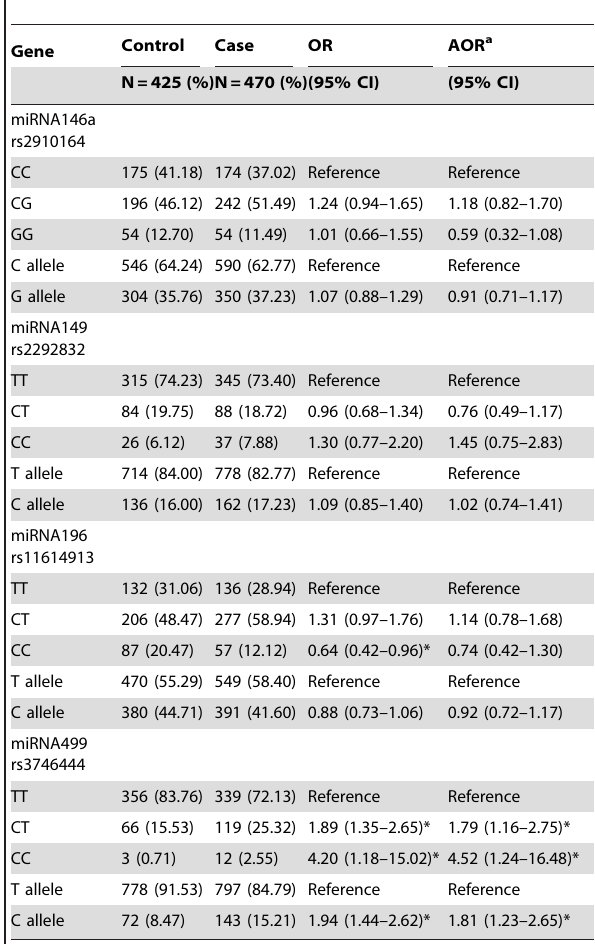
Table 2. Distribution of miRNA genotypes in healthy controls and oral cancer